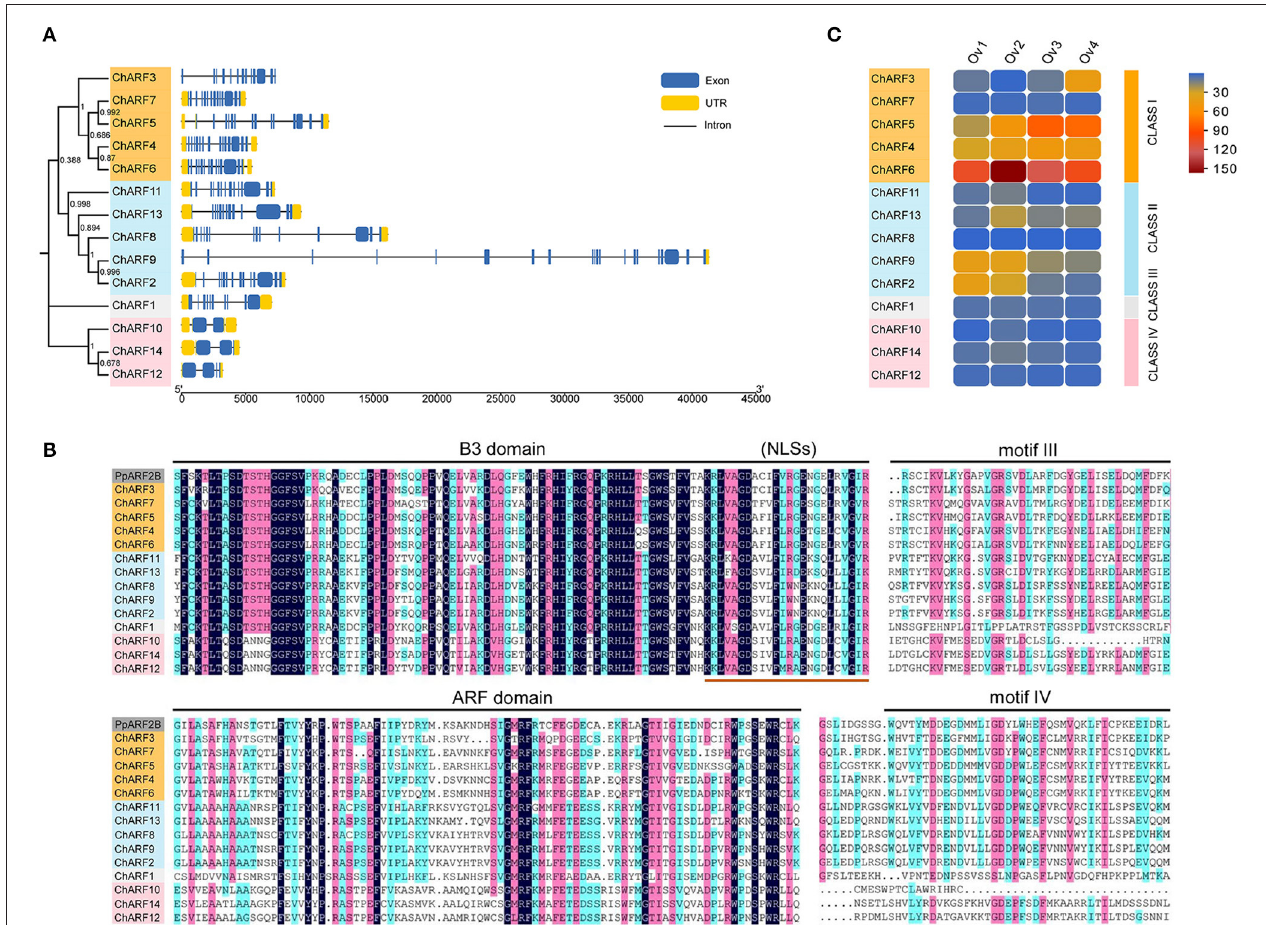
FIGURE 2 | Gene structures, multiple sequence alignment and expression pattern analysis. (A) Gene structures of ChARF family genes. The untranslated region (UTR), exon and intron are represented by yellow box, blue box and black line, respectively. (B) Multiple sequence alignment of ChARF family proteins. The B3 domain, Auxin_resp (ARF) domain, motif III and motif IV domain are marked by lines. The ends of the B3 domains include classical nuclear localization signals (NLSs). (C) Expression pattern heatmap of ChARF family genes during ovule developmental stages. Expression is normalized based on the value of fragments per kilo base of exon per million fragments mapped (FPKM) and the heatmap was constructed by Evolview online